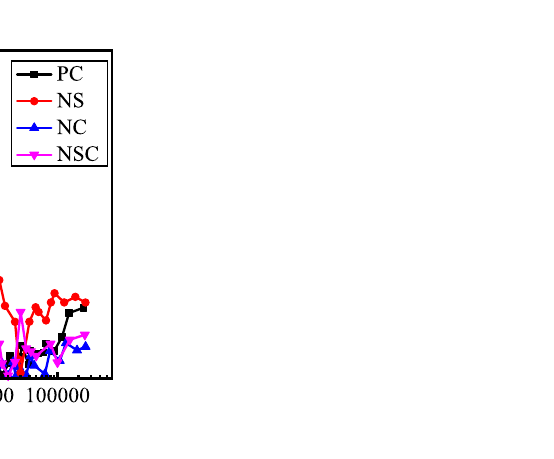
Figure 21. Pore size distribution curve of